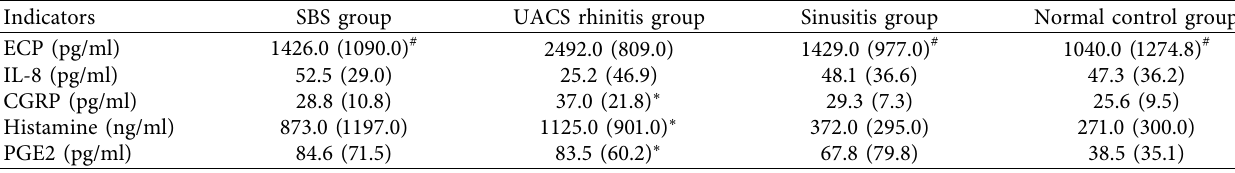
Table 3: Comparison of inflammatory mediators in the induced sputum supernatants in each